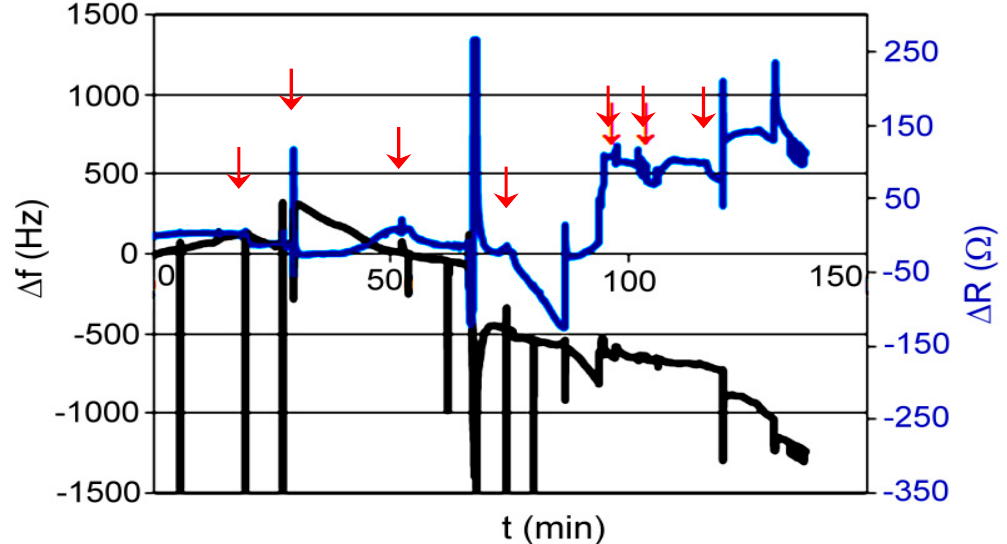
Figure 18. Changes of frequency in time for XVIII polymer; absorbed compound—ethylenediamine in